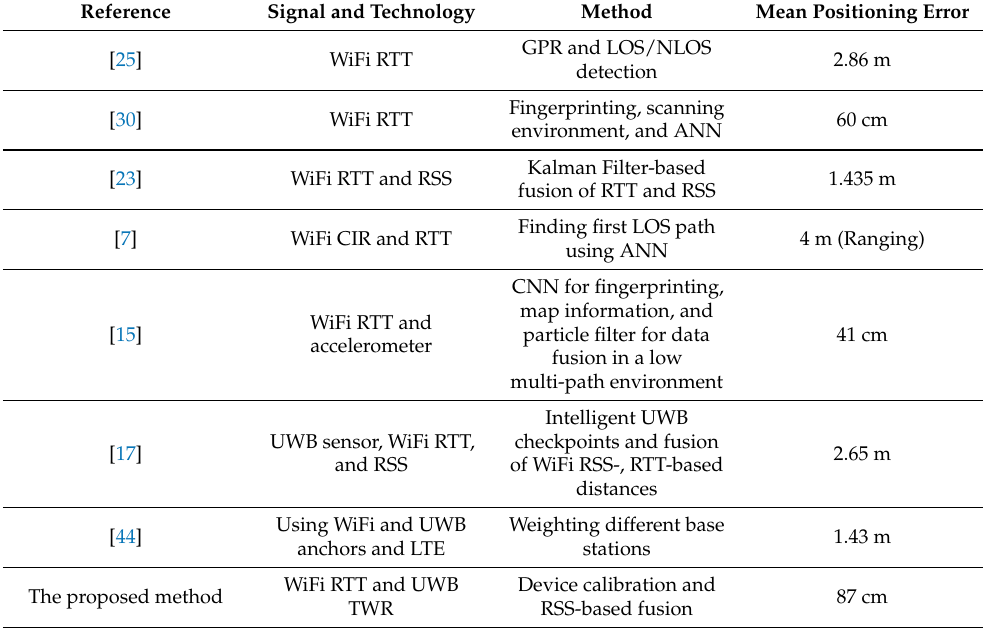
Table 2. Proposed methods in the literature to overcome UWB and WiFi limitations for positioning